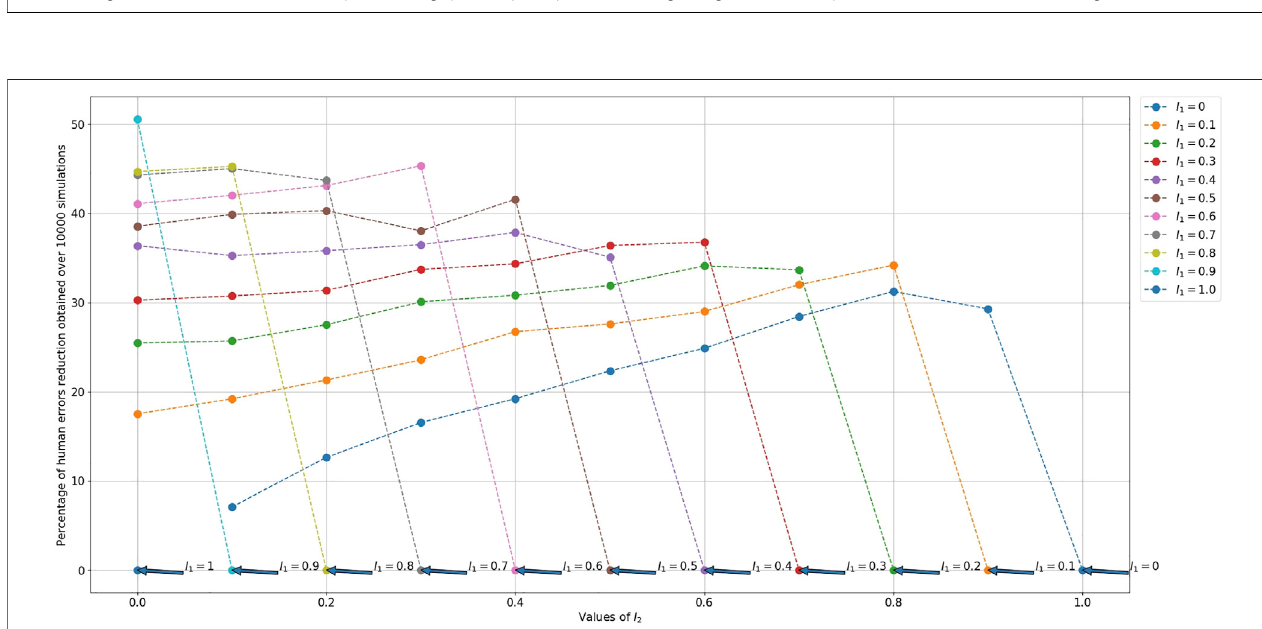
FIGURE 7 | Percentage of time improvement between C 3 and C 1 for a 4-cube puzzle. t A P ( A h , w ) (cid:2) I 2 ,and P ( A h , b ) (cid:2) I 3 (cid:2) 1 − ( I 1 + I 2 ).Inthis fi gure,eachdottedlineisequivalenttoaspeci fi c I 1 value.Eachdotcorrespondstoa I 2 value(readonthex-axis).Foreach dot knowing I